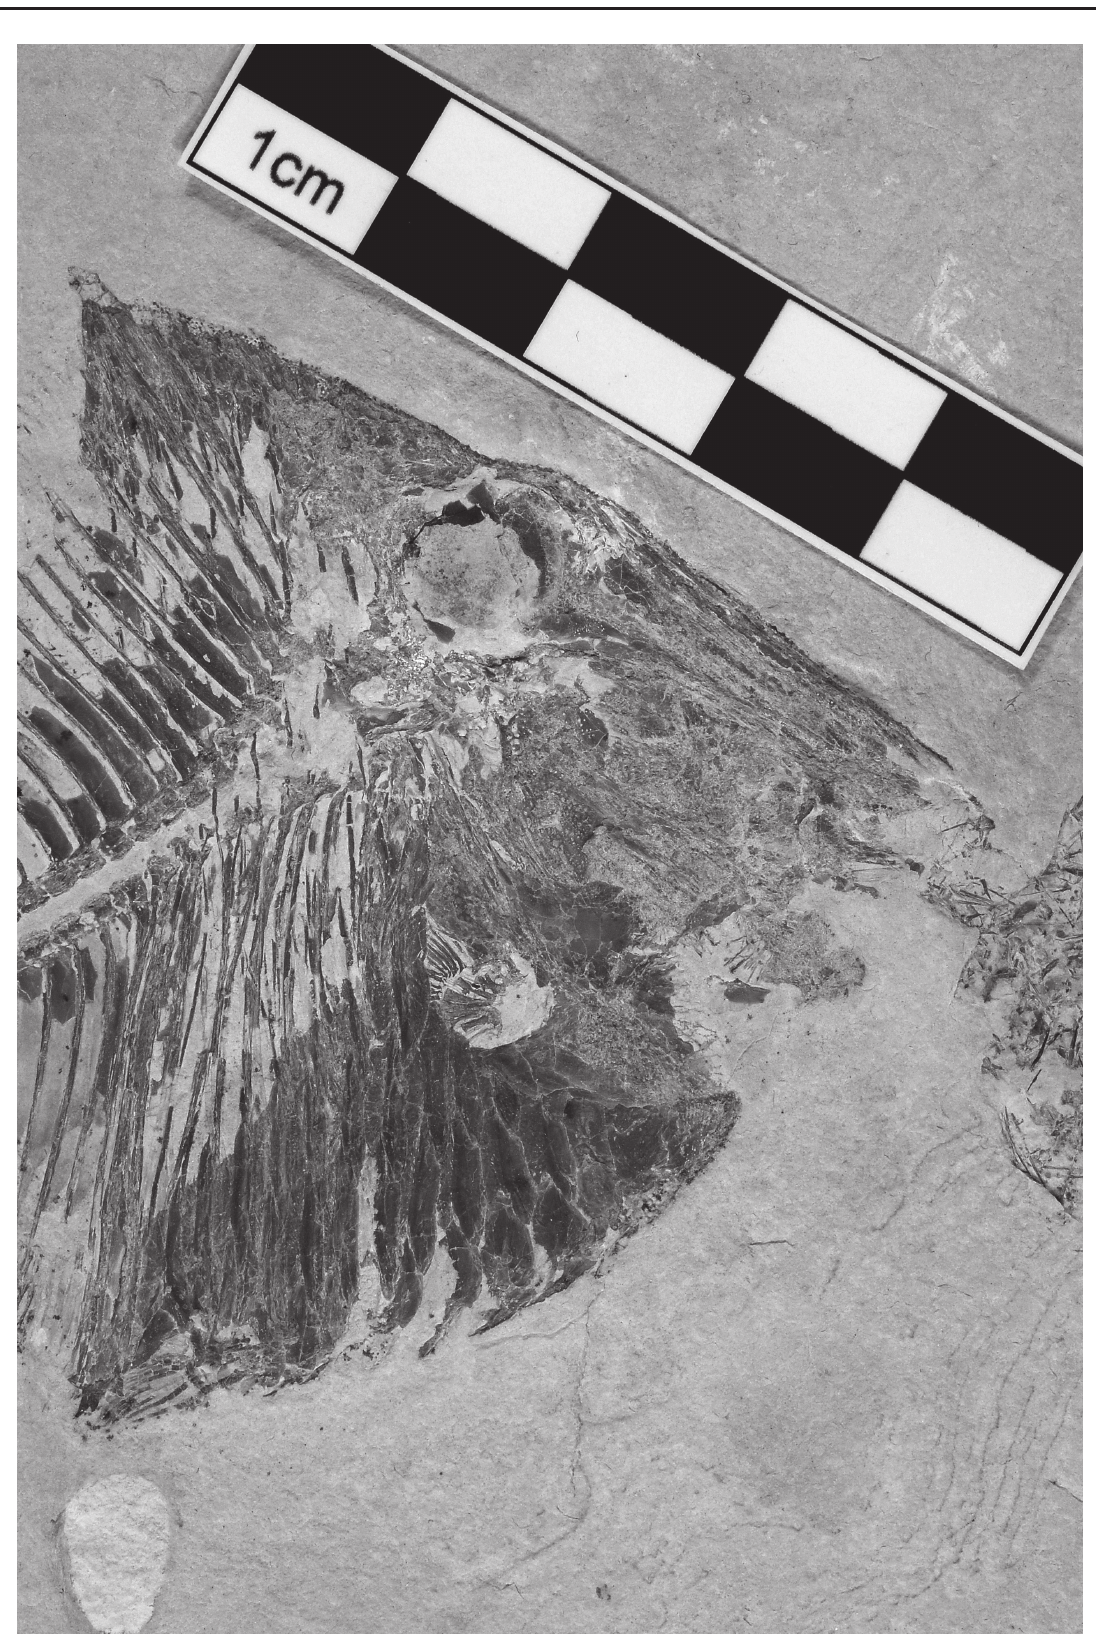
Fig. 6. Acrorhinichthys poyatoi gen. et sp. nov. Head and anterior region of the holotype